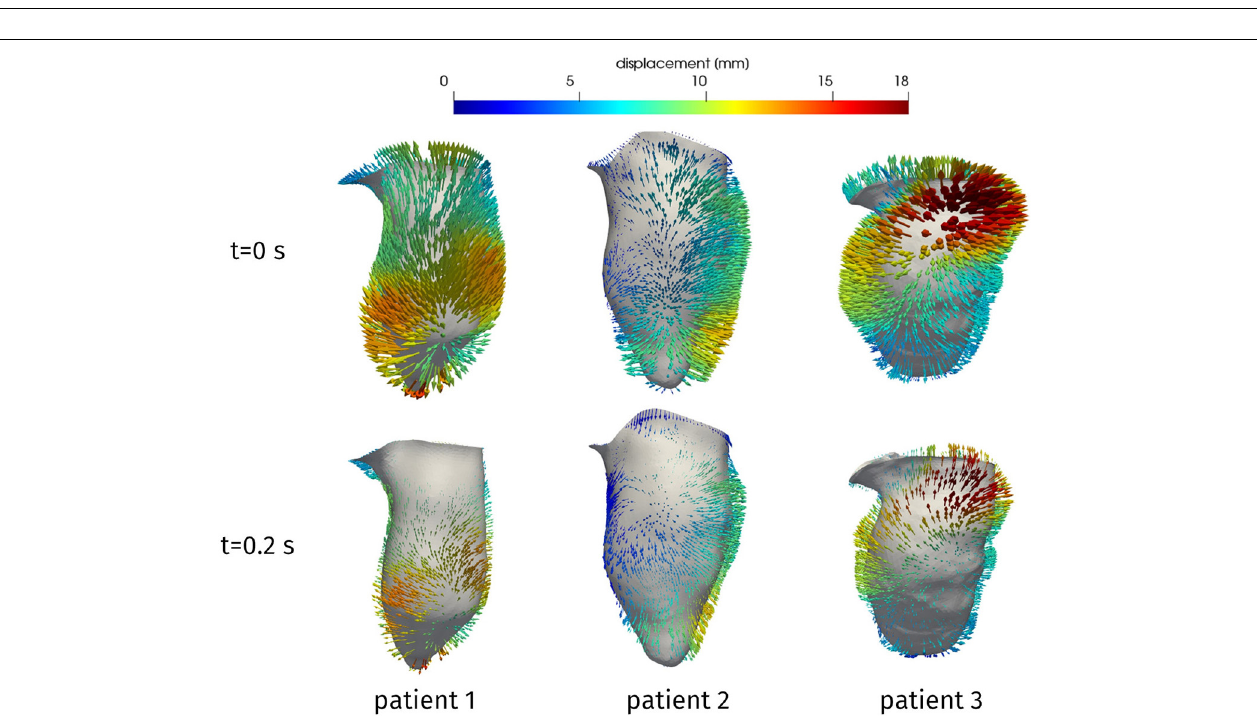
FIGURE 3 | Computational mesh for the patients under investigation. In the box, a zoom showing the local refinement in the LVOT.